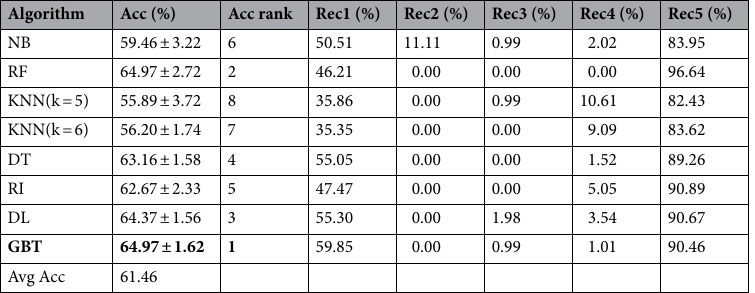
Table 4. The performance of different classification algorithms on 5-class-dataset according to fgose.